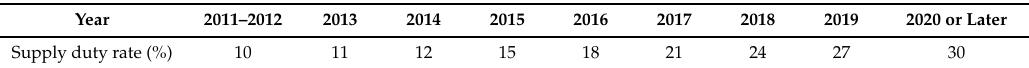
Table 1. Renewable energy supply duty rates in